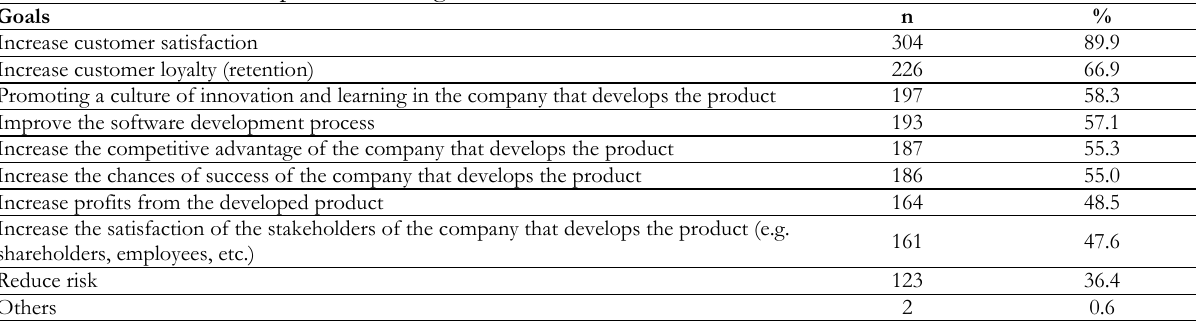
Table 8. Impacts of the Adoption of Strategies